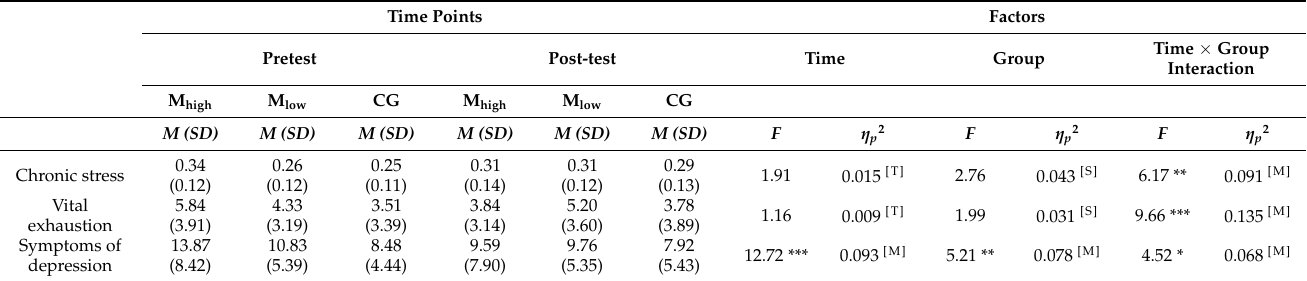
Table 4. Descriptive and inferential statistical indices for chronic stress, vital exhaustion and symp- toms of depression, at pre- and posttest, separately for motivation high (M high ), motivation low (M low ), and for the control group